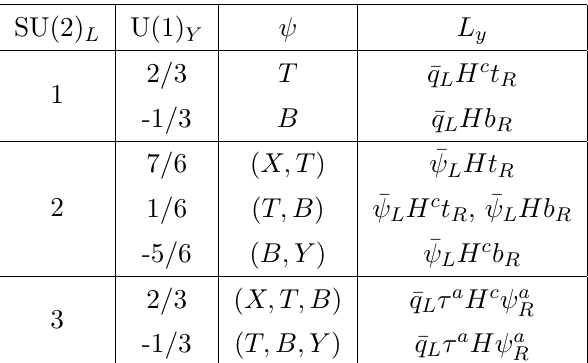
Table 1 . VLQs multiplet quantum numbers under SU(2) L and U(1) Y that allows to write gauge invariant renormalizable interactions with the SM sector through Yukawa-type terms. The U(1) em quantum numbers of the X; T; B and Y VLQs are 5/3, 2/3, -1/3 and -4/3 respectively. Polarisation Pair production Single production observed SM expectation observed SM expectation